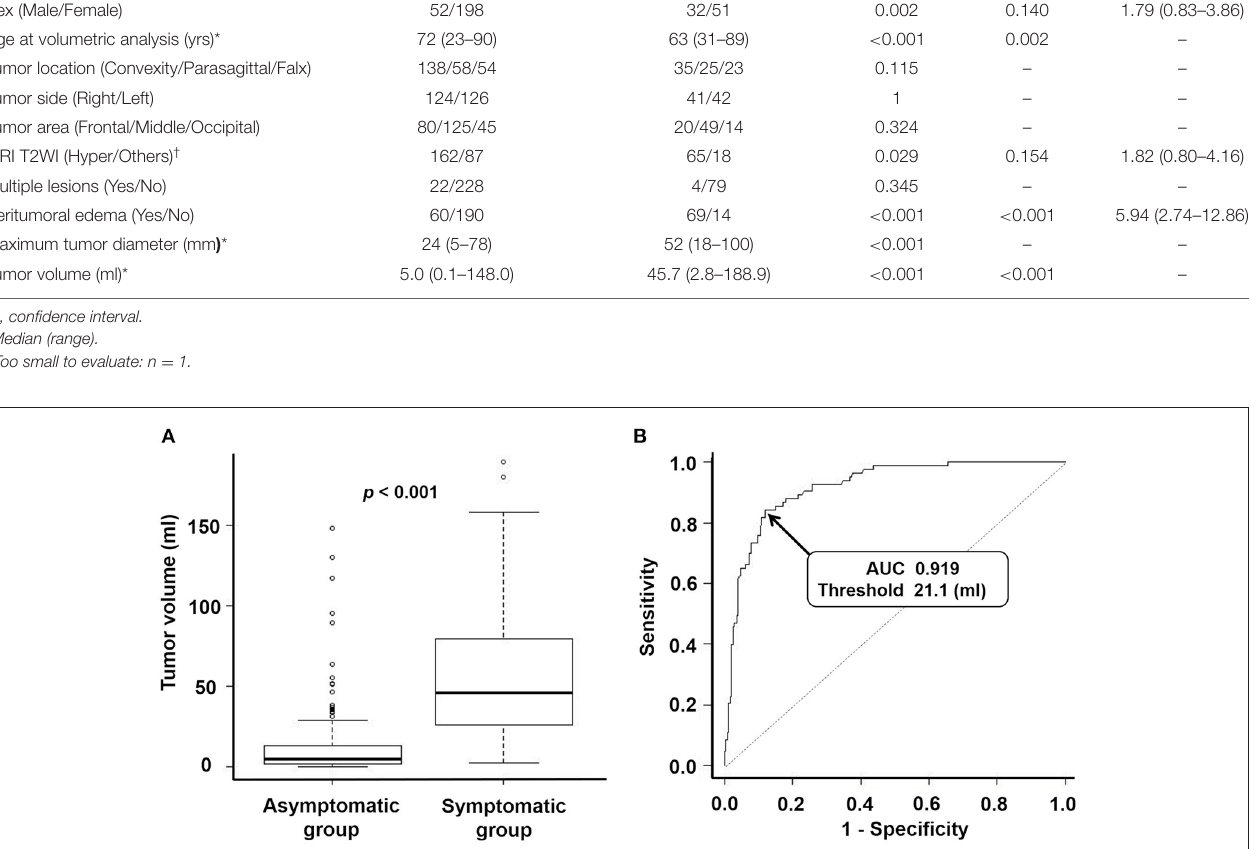
FIGURE 2 | (A) Box-and-whisker plots representing tumor volume of an asymptomatic group and symptomatic group. The median tumor volume of the asymptomatic group and the symptomatic group were 5.0ml and 45.7ml, respectively. P -value for the Mann-Whitney U test: < 0.001. (B) Receiver operating characteristic curve for predicting which patients will become symptomatic via tumor volume. Area under the curve: 0.919 (95% confidence interval: 0.887–0.951). Threshold for tumor volume: 21.1ml. Sensitivity: 0.843. Specificity: 0.880.